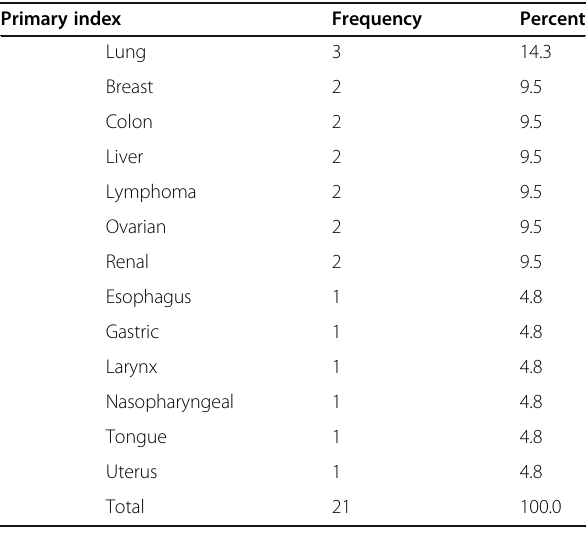
False-negative Malignant lesions excluded by PET/CT but malignancy detected by pathological examination. Statistical analysis of data in terms of frequencies (number of cases) and percentages are provided when appropriate. False-/true-positive and positive predictive values and rate were calculated to test val- idity of PET/CT in detection of extra primary. The correlation of PET/CT findings with standard refer- ence was analyzed using χ 2 test. P values < 0.05 were considered statistically significant.